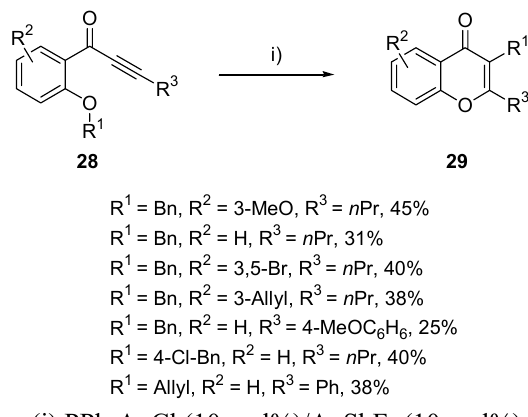
Scheme 10. Synthesis of chromones by gold-catalyzed